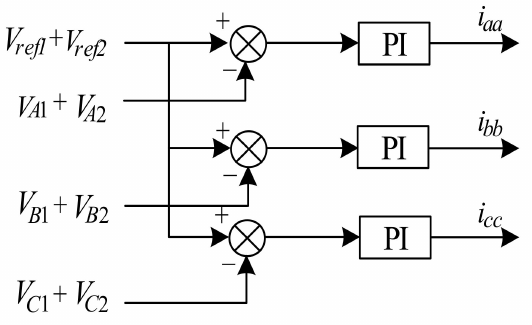
Figure 8. Integrated control strategy of phase voltage.